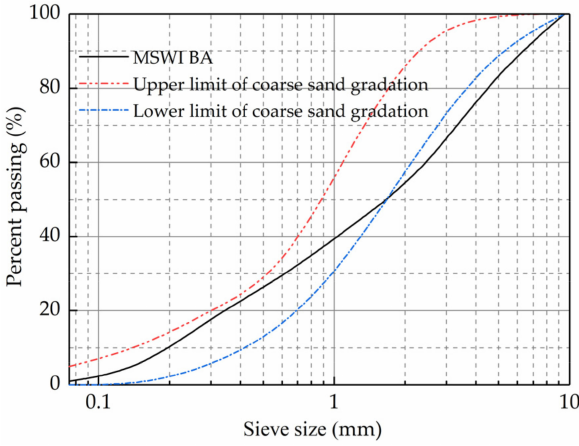
Figure 2. Gradation curve of MSWI BA.